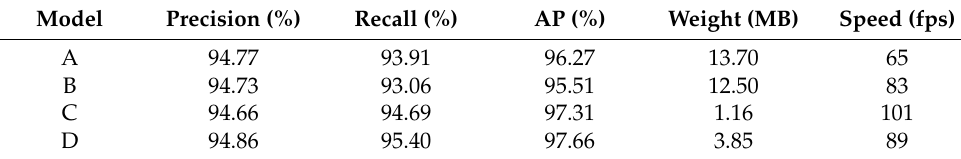
Figure 10. Structures of different depth feature fusion. Table 3. Comparative analysis of several depth feature fusion structures.